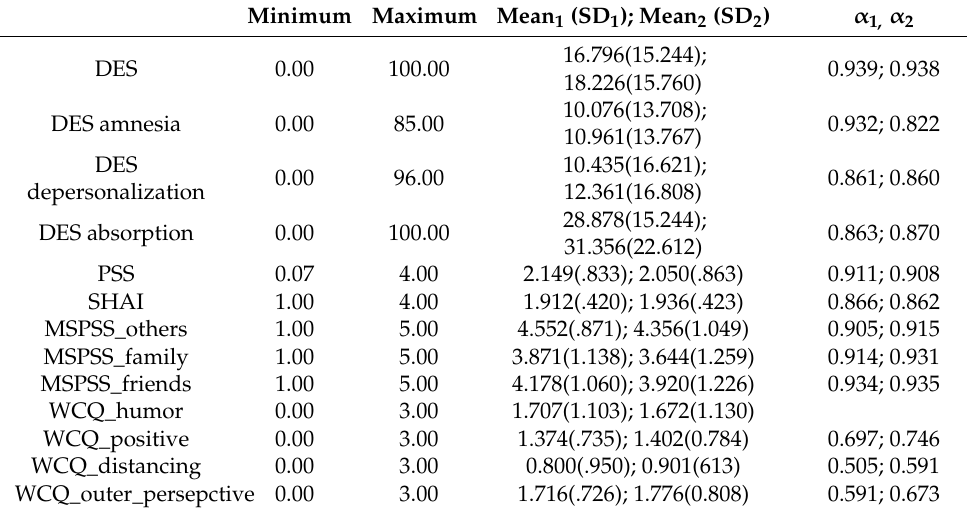
Table 3. Descriptive statistics for variables of the Hungarian